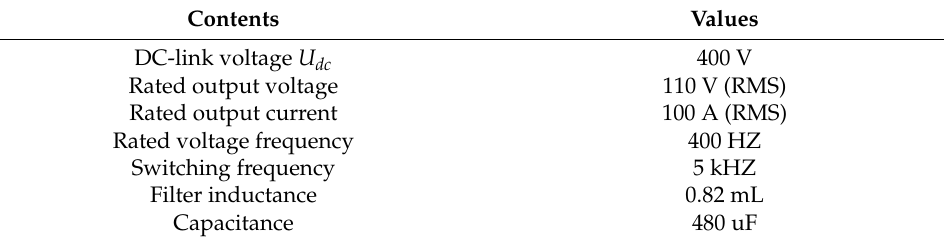
Table 4. Parameters of real system